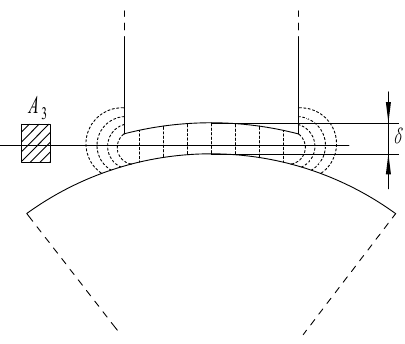
Figure 5. Magnetic flux distribution in the air gap.